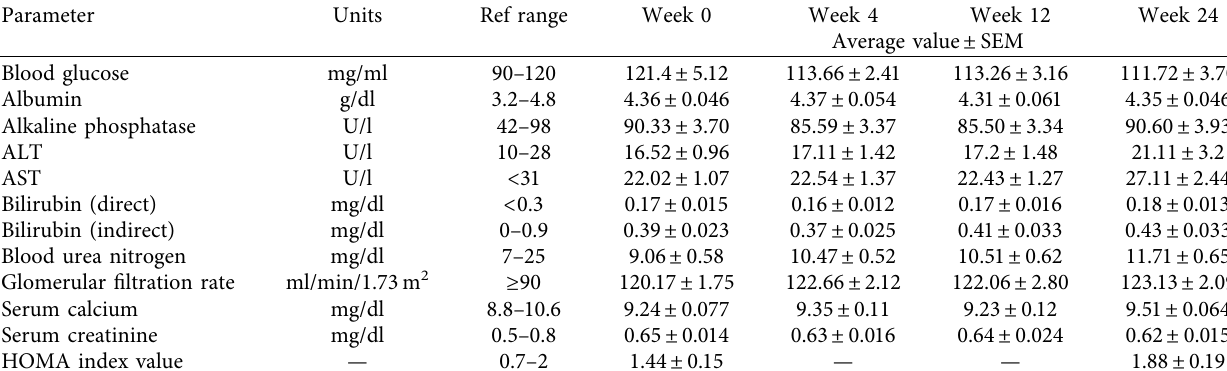
Table 2: Biochemical parameters measured during the course of study.